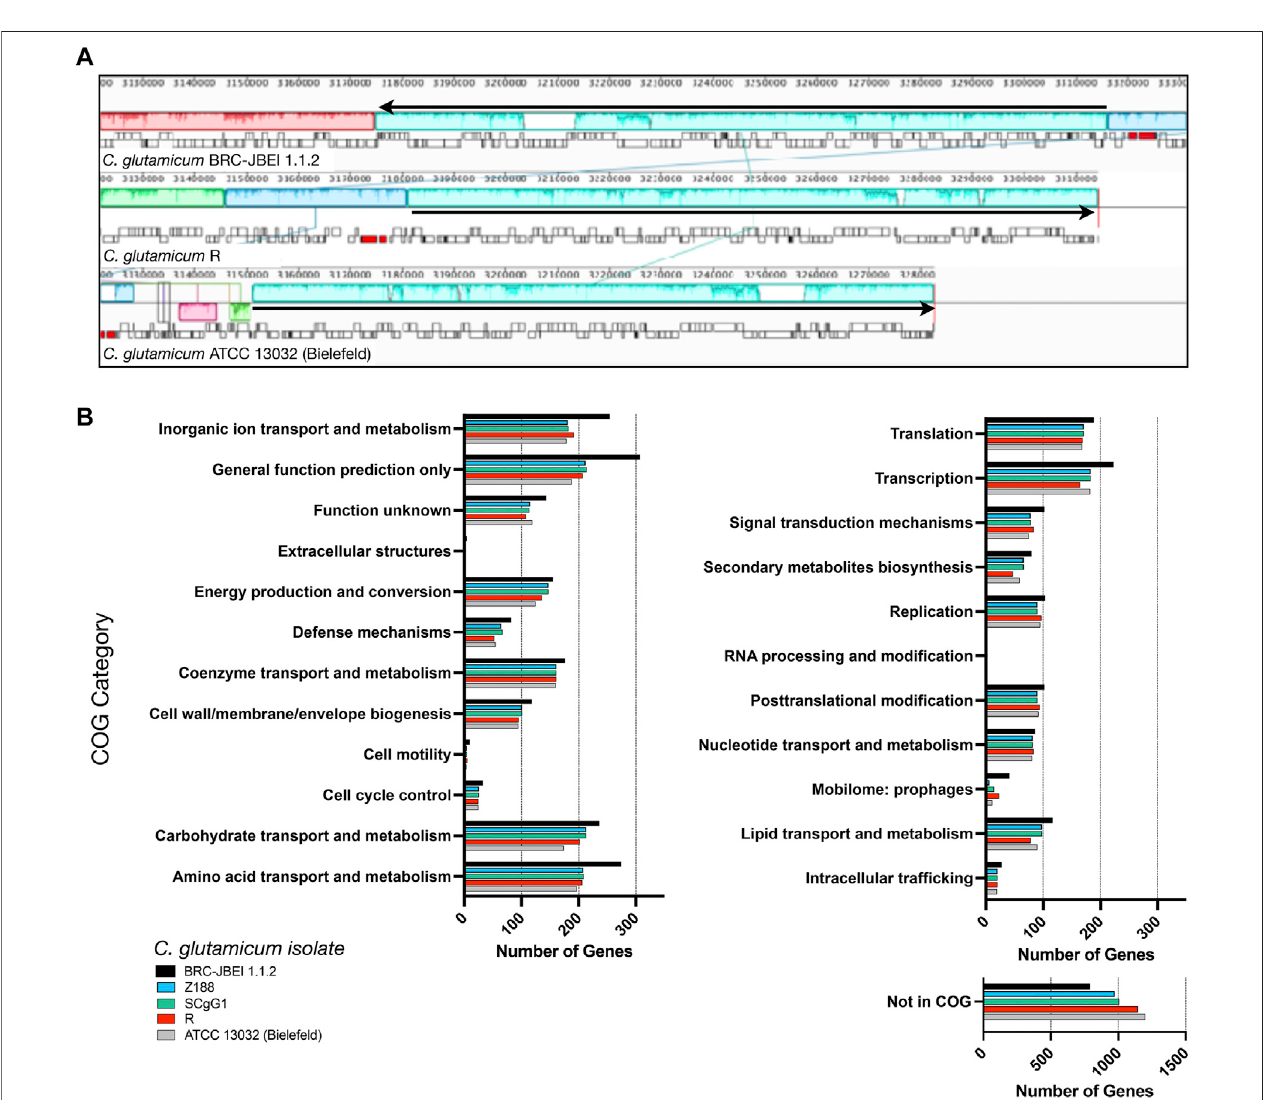
FIGURE2| Comparisonofthe C.glutamicum BRC-JBEI1.1.2strainwithcloselyrelated C.glutamicum strains, (A) Ameta-analysisofgenefunctionusingclusters of orthologous genes (COGs) analysis. The total number of genes in each category for each strain is represented with colored bars as indicated, (B) Mauve genome alignment of C. glutamicum BRC-JBEI 1.1.2 with C. glutamicum R and 13032 (Bielefeld). Similar genomic regions share the same color across the three different genomes compared. A 140 kb chromosomal inversion is highlighted in light blue, and the relative direction of the inversion in each strain is indicated with a black arrow. Individual genes are indicated with open rectangles underneath the colored